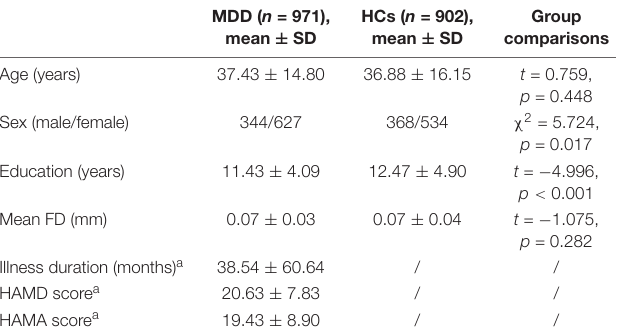
TABLE 2 | Comparisons on demographic/characteristics between the MDD and HC